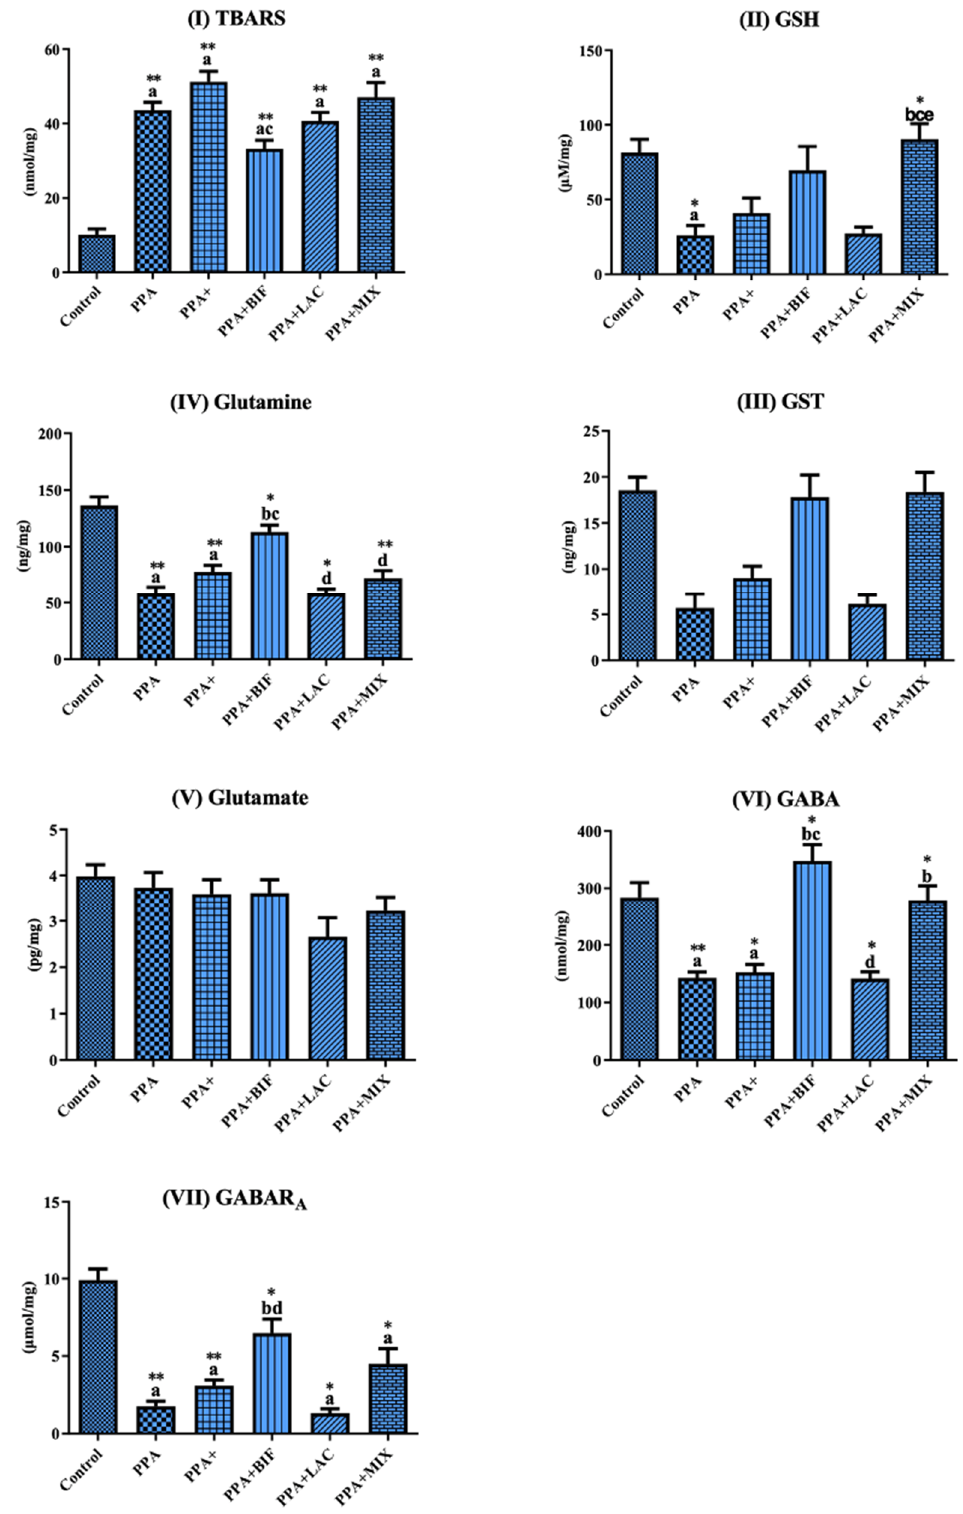
Figure 1. Concentrations of ( I ) TBARS, ( II ) GSH, ( III ) GST, ( IV ) glutamine, ( V ) glutamate, ( VI ) GABA, and ( VII ) GABAR A in the brain homogenates of male western albino young rats in all groups. (a) Control vs. all groups, (b) PPA vs. all groups, (c) PPA + vs. therapeutic groups, (d) PPA + BIF vs. PPA + LAC and PPA + BIF vs. PPA + MIX, and (e) PPA + LAC vs. PPA + MIX. (*) The mean difference is significant at p ˂ 0.001, and (**) the mean difference is significant at p ˂ 0.0001 .